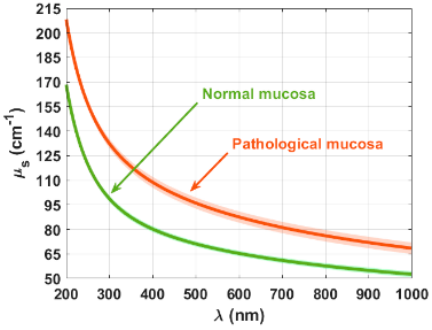
Figure 10. Calculated µ s ( λ ) curves for the normal and pathological mucosa. Both curves in Figure 10 show the expected smooth-decreasing behavior, and low SD values along the entire spectral range, meaning that scattering is not too di ff erent from one sample to another within the sample groups of normal and pathological mucosa used in the present study. Similar to (cid:48) what was observed for µ s , the pathological mucosa presents higher magnitude values for deep-UV, indicating a higher protein content. The curves presented in Figure 10 are described by the following equations, which were obtained with R-square values of 0.9978 (normal mucosa) and 0.9989 (pathological mucosa).